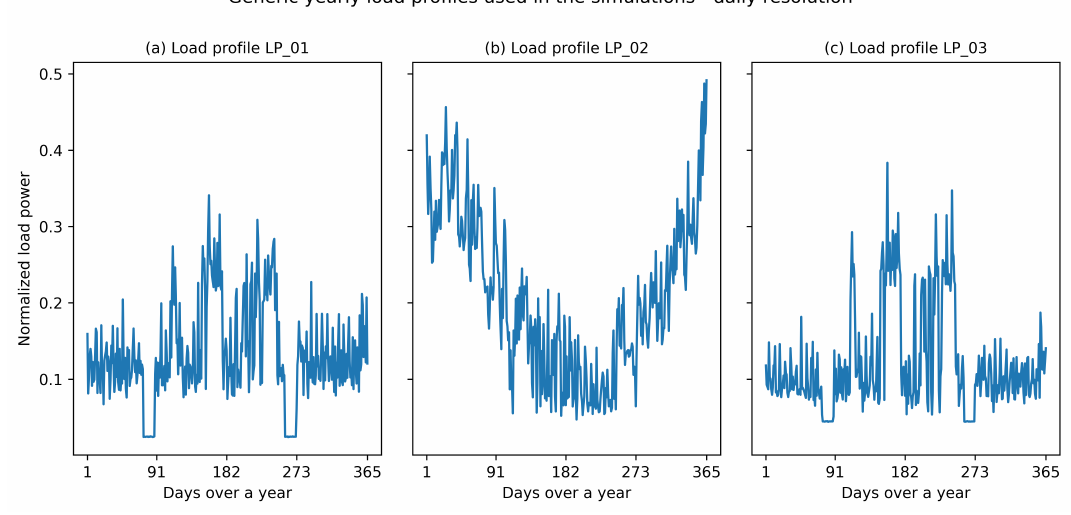
Figure 10. Load shapes with daily resolution: ( a ) LP 01; ( b ) LP 02; ( c ) LP 03.